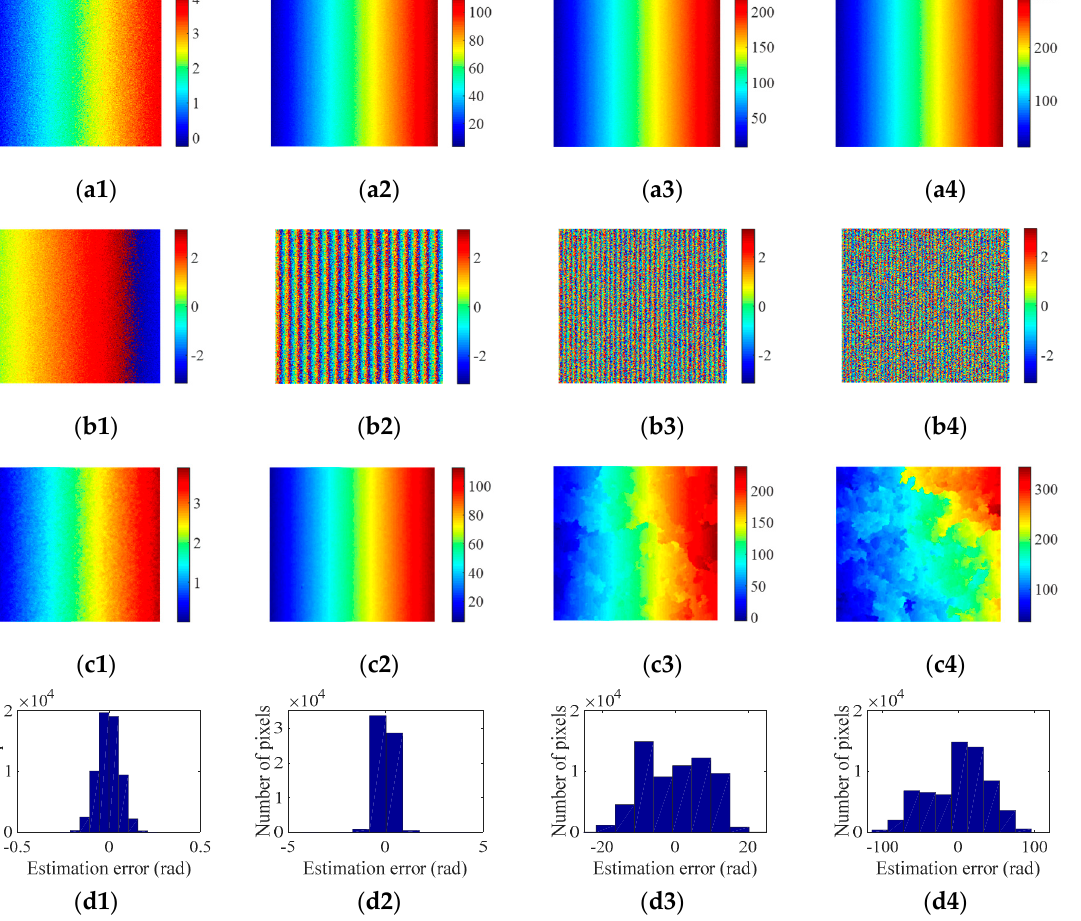
Figure 3. Simulated and unwrapped phase maps of different perpendicular baselines with η = 2 ◦ . The numbers 1, 2, 3 and 4 correspond to baseline lengths of 100 m, 3000 m, 6000 m, and 8000 m, respectively. ( a ) Interferometric phase with noise; ( b ) wrapped interferometric phase; ( c ) unwrapped phase; and ( d ) estimation error histogram.